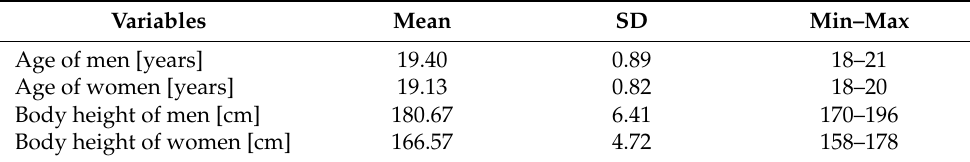
Table 1. Age and body height of male and female university students at the beginning of the study. Variables Mean